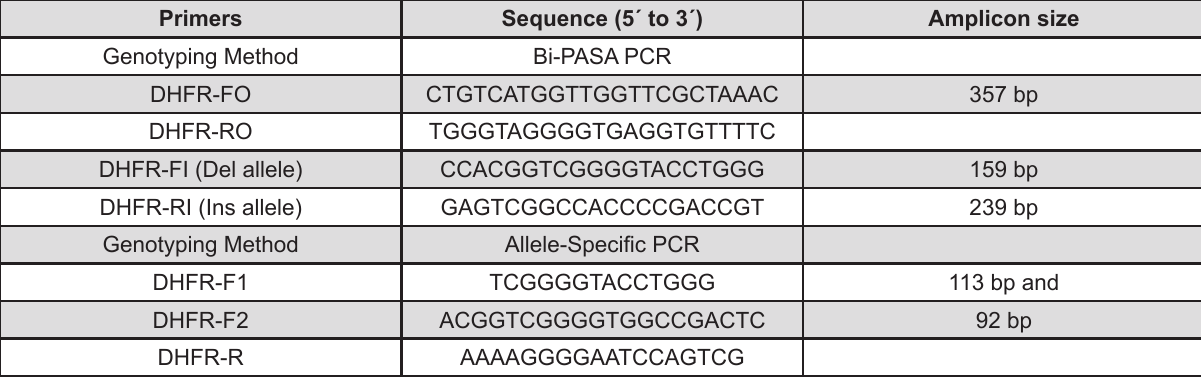
Figure 1- Primers sequence for detection of DHFR 19-bp deletion